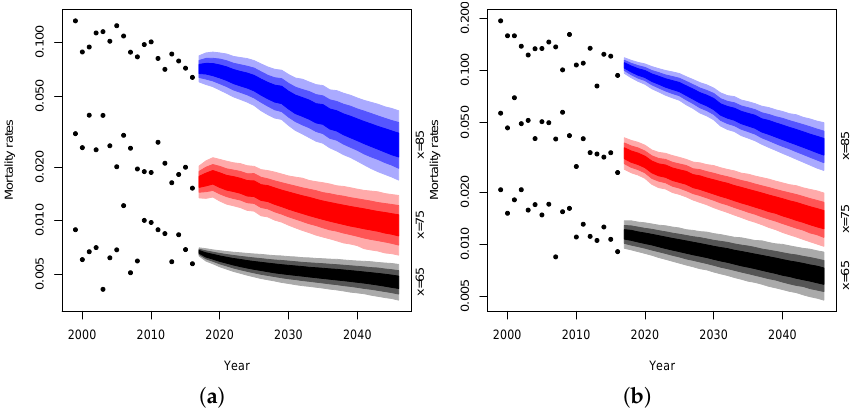
Figure 13. Mortality rate projections at age 65, 75, 85 with RH–LC model: ( a ) female Maltese population, ( b ) male Maltese population.